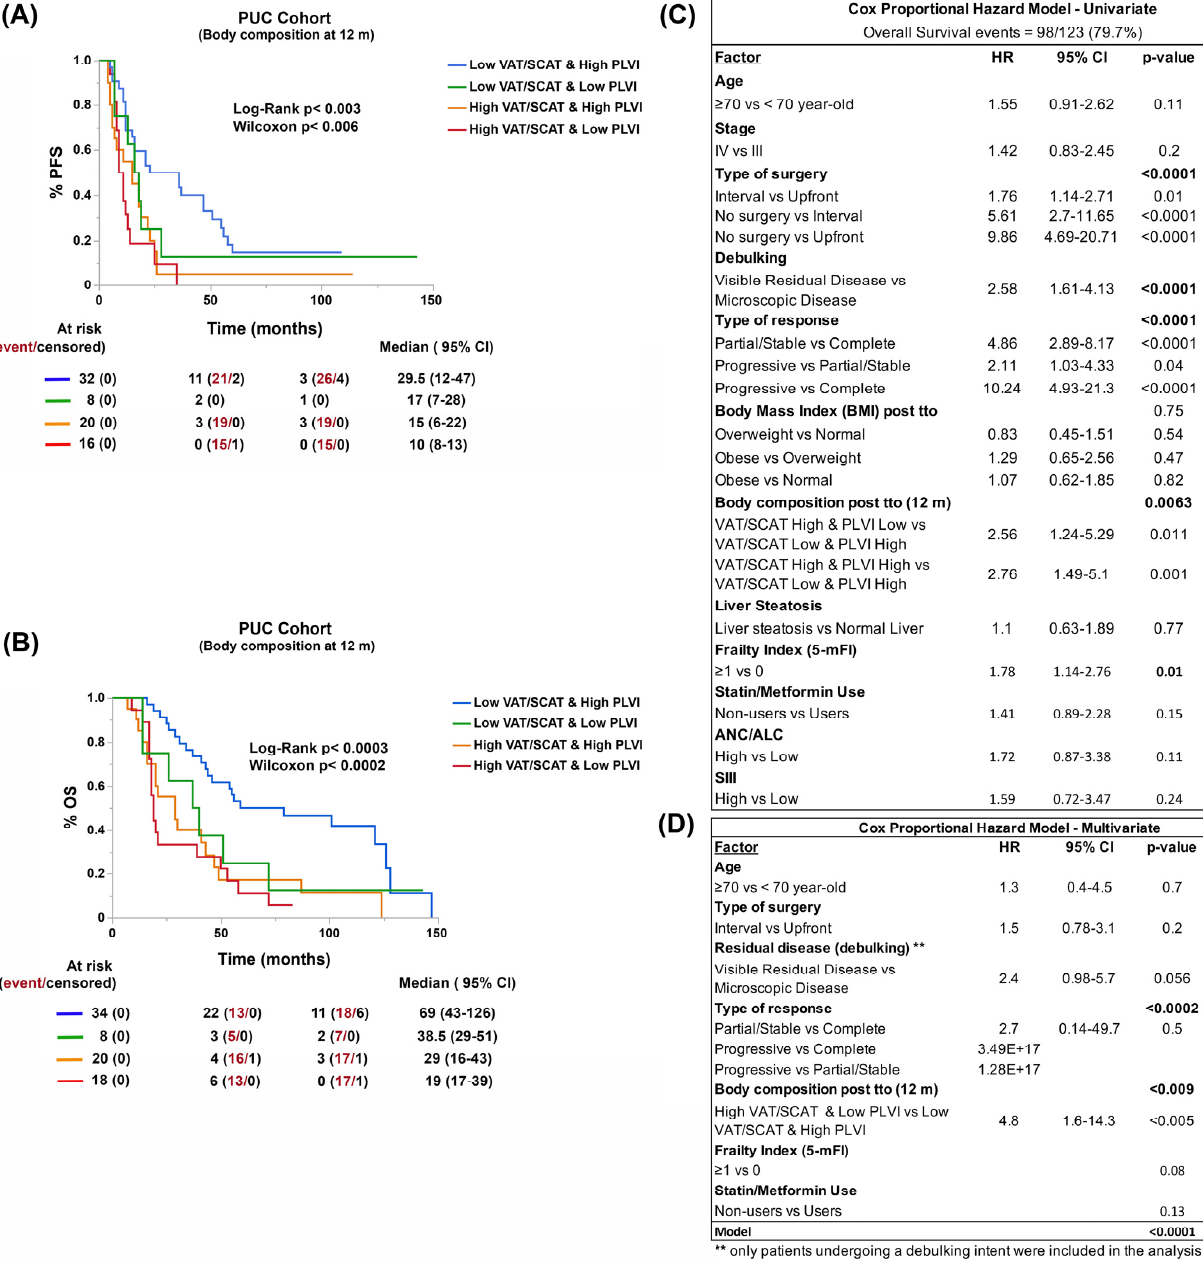
Figure 6. Effects of body composition (BC) changes (estimated by VAT/SCAT and PLVI) after one-year treatment on progression-free (PFS, A ) and overall survival (OS, B ) in the PUC cohort . Univariate and multivariate Cox proportional regression analyses ( C , D ) carried out to assess BC as an independent risk factor.